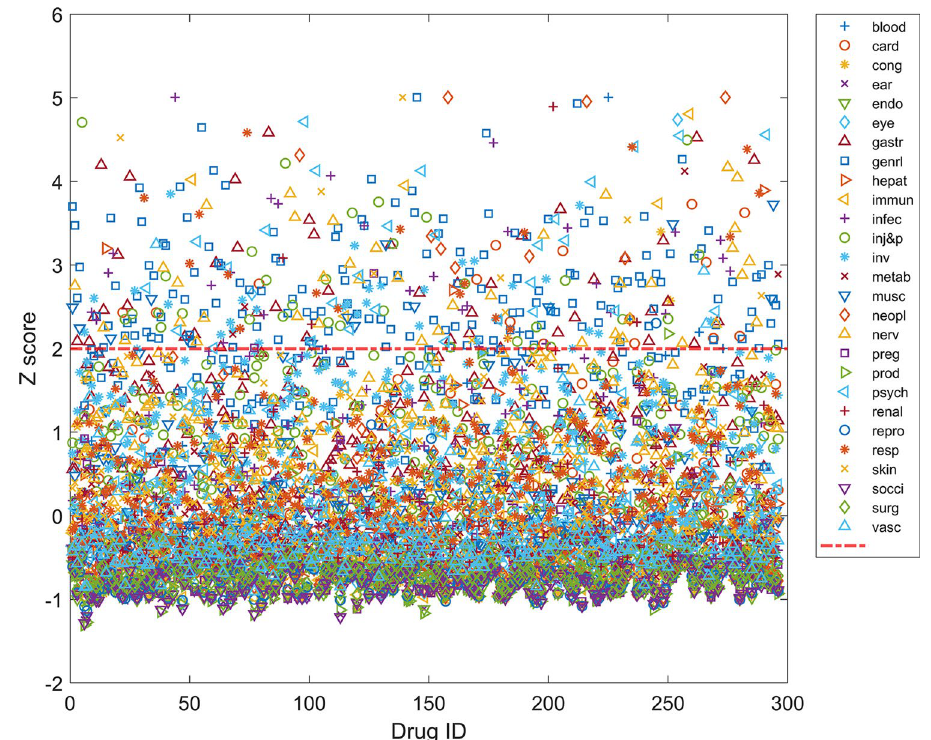
Figure 3. Z-scores of adverse events in SOCs. The x-axis indicates the drug ID which can be found in Supplementary Table 1. Colors and shapes for SOCs are given in the right legend in which the SOC abbreviations can be found in Supplementary Table 3. The red dashed line represents the